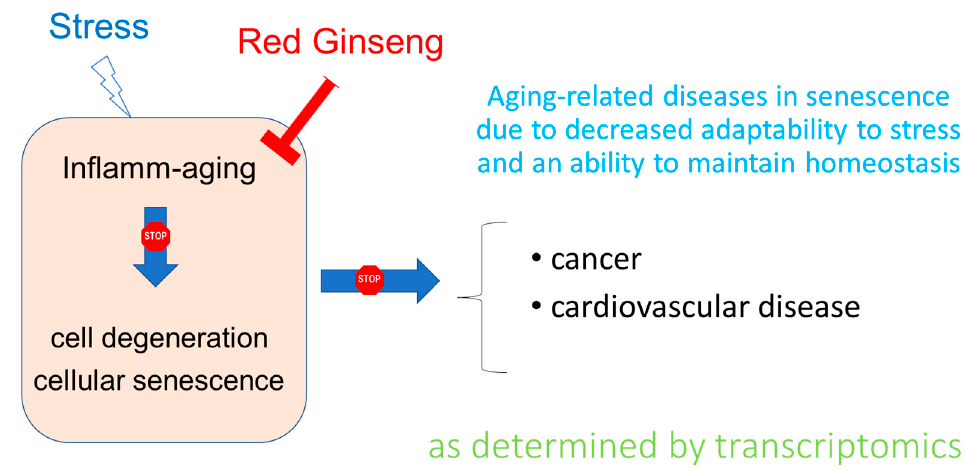
Figure 8. Hypothetical scheme of the effect of Ginseng on aging-related diseases as determined by transcriptomics.